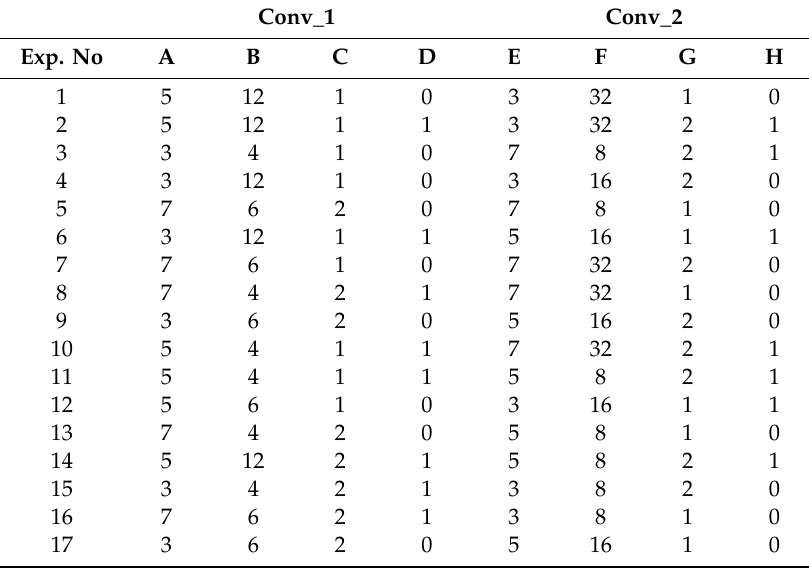
Table 6. UL of U 17 (17 8 ) used to allocate the eight factors with 17